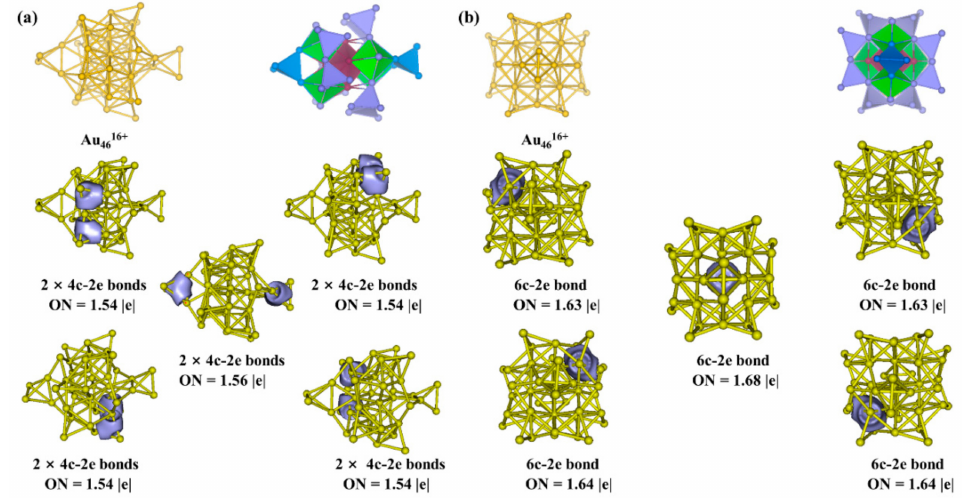
Figure 4. Structures, superatom-network models and adaptive natural density partitioning (AdNDP) localized natural bonding orbitals of ( a ) 4 c –2 e bonds (side view), ( b ) 6 c –2 e bonds (top view) in Au 4616 + core of Au 70 S 20 (PCH 3 ) 12